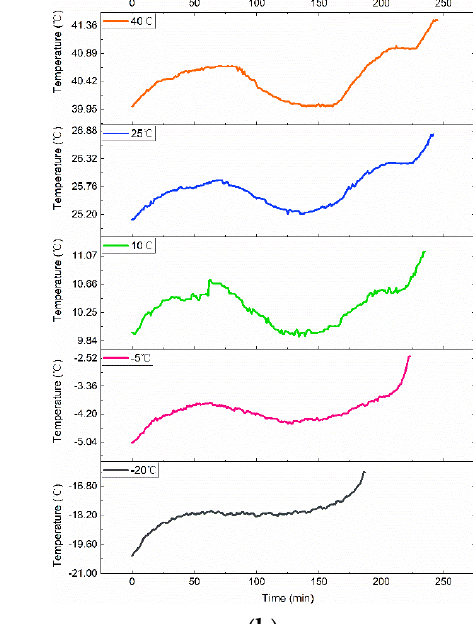
Figure 4. Discharge voltage change curve: ( a ) 0.1C discharge rate; ( b ) 0.25C discharge rate; ( c ) 0.5C